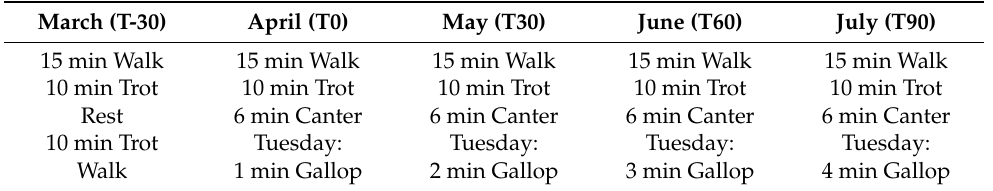
Table 1. Table showing the daily training program completed by each horse involved in the study.